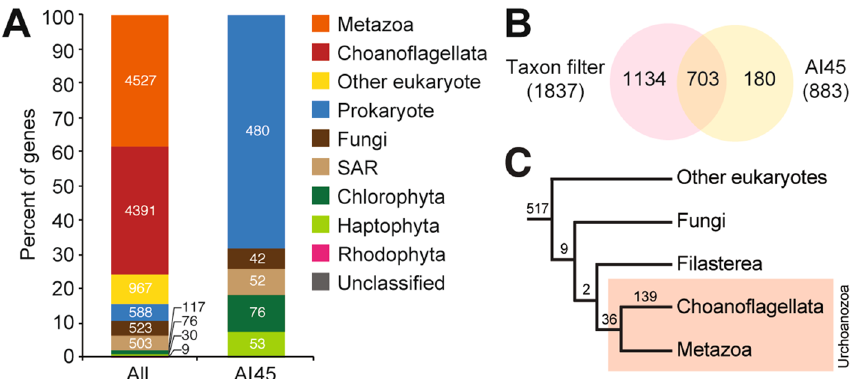
Figure 1. HGT candidates in the S. rosetta genome. ( A ) Taxonomic affiliation of all S. rosetta genes and genes that passed the Alien Index analysis (AI45). ( B ) Number of putative HGTs detected based on taxonomic affiliation (taxon filter) and Alien Index (AI45) analysis. ( C ) Number of HGT candidates with orthologs in other eukaryotic